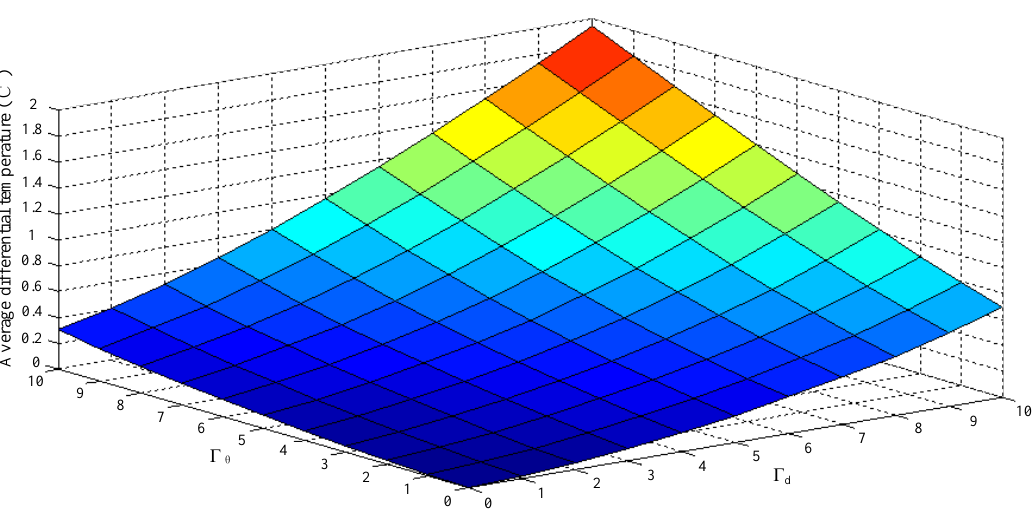
Figure 5. The average temperature differences under crossed influence the uncertainties.